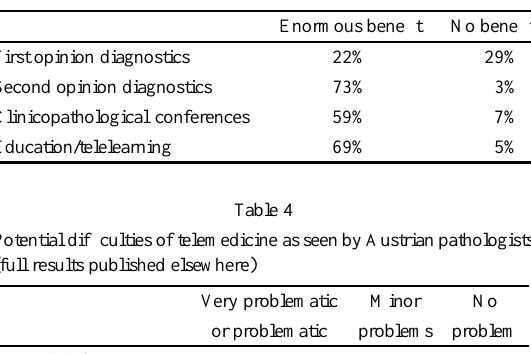
Potential benefits of telemedicine as seen by Austrian pathologists (full results published elsewhere)